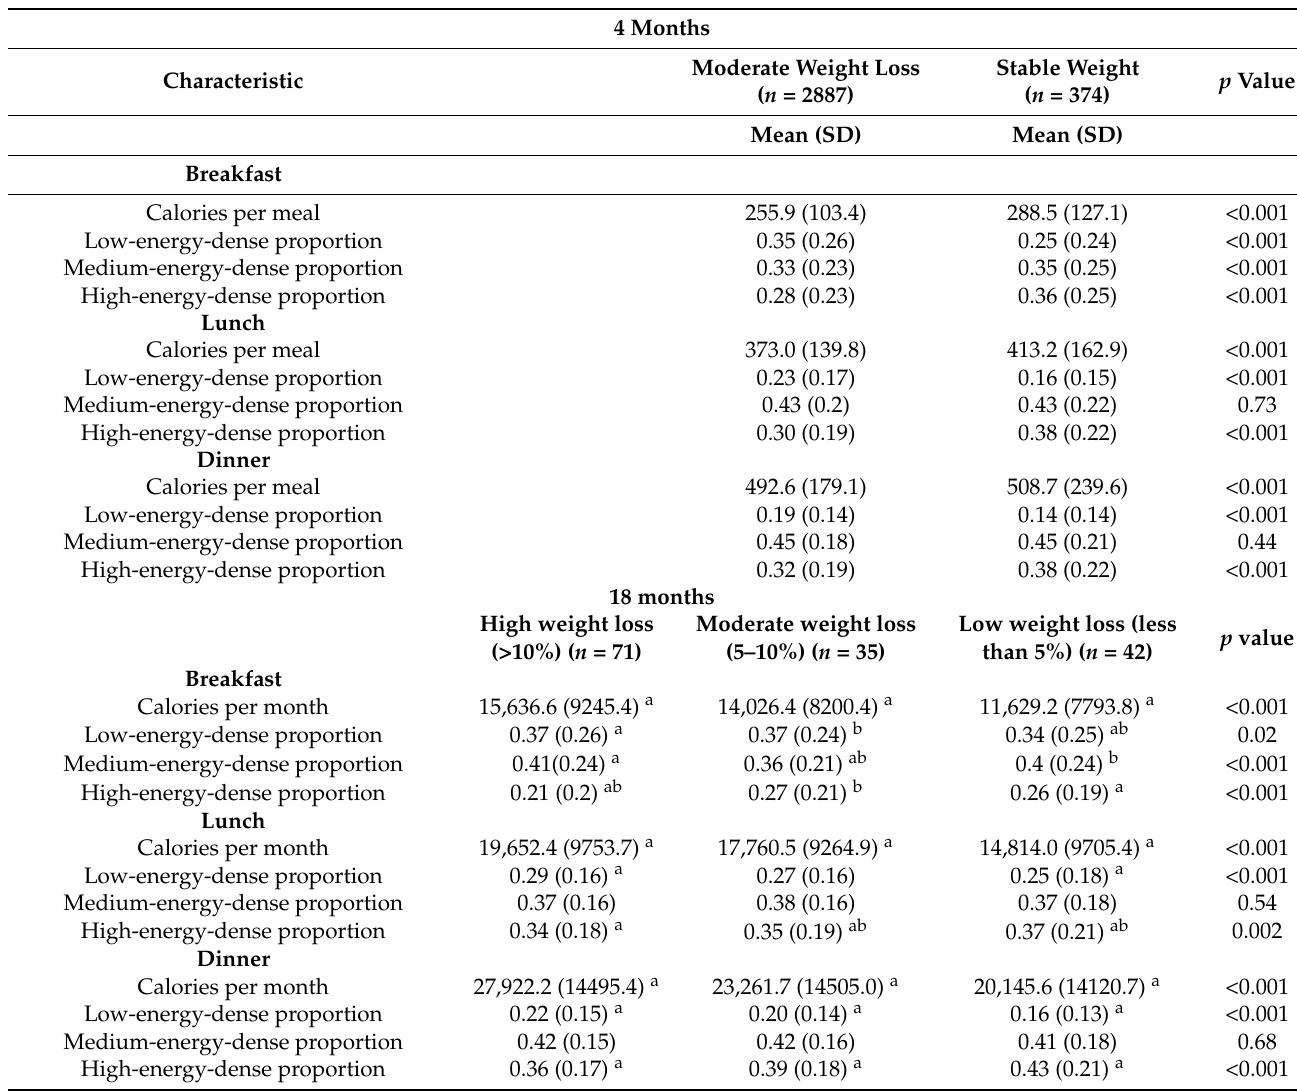
Table 2. Energy density proportions at 4 months and 18 months.